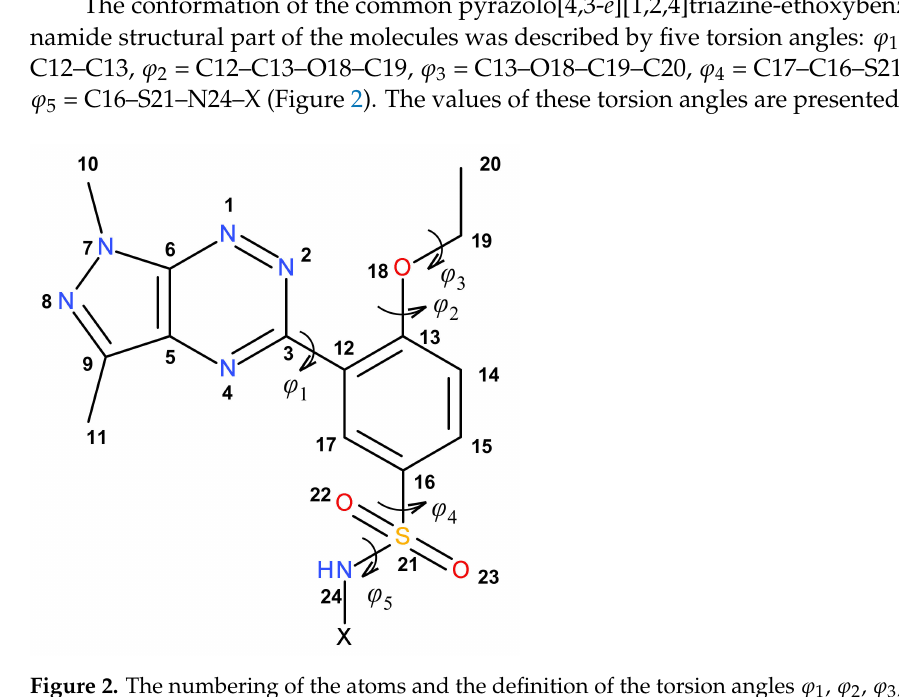
Figure 2. The numbering of the atoms and the definition of the torsion angles ϕ 1 , ϕ 2 , ϕ 3 , ϕ 4 and ϕ 5 , describing the conformation of the pyrazolo[4,3- e ][1,2,4]triazine-ethoxybenzene-sulfonamide part of molecules 8a – m . Table 1. The torsion angles ϕ 1 , ϕ 2 , ϕ 3 , ϕ 4 and ϕ 5 ( ◦ ) calculated at the DFT/B3LYP/311++G(d,p) level for 8a – m